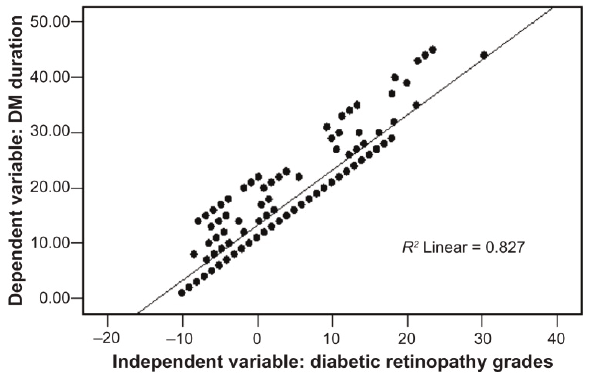
Figure 1: Correlation of the Diabetic Retinopathy with duration of Diabetes Mellitus